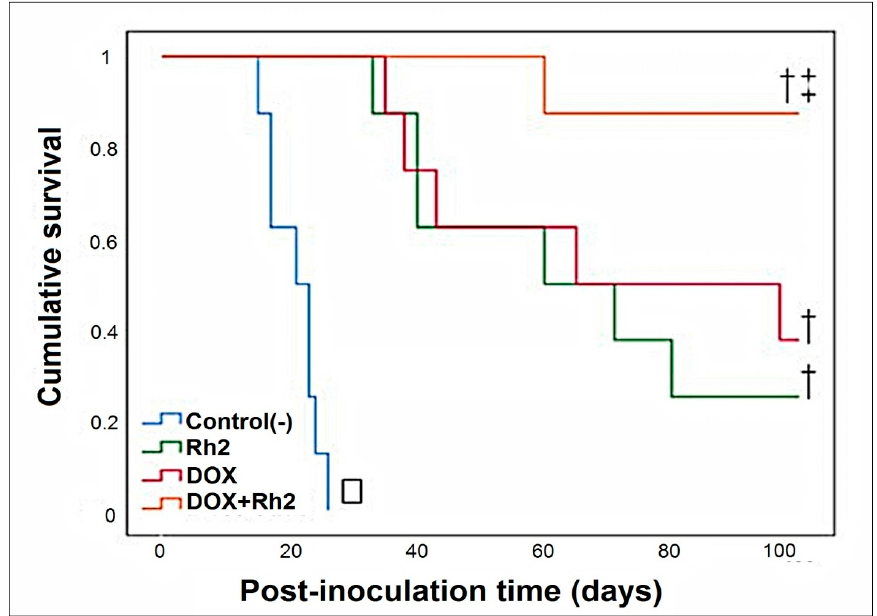
Figure 4. The enhanced effect of DOX + Rh2 co-treatment on ascites adenocarcinoma. Kaplan–Meier survival plot of tumor-inoculated animals treated with DOX or Rh2 alone, and DOX + Rh2 combination. Statistical analysis for the survival curves was carried out using the log-rank test. p < 0.05 was considered statistically significant. □ Log-rank (Mantel-Cox) p < 10 − 4 . † Pairwise post hoc versus control (Mantel-Cox), p < 0.05. ‡ Pairwise post hoc versus Dox or Rh2 (Mantel-Cox), p < 0.00005.